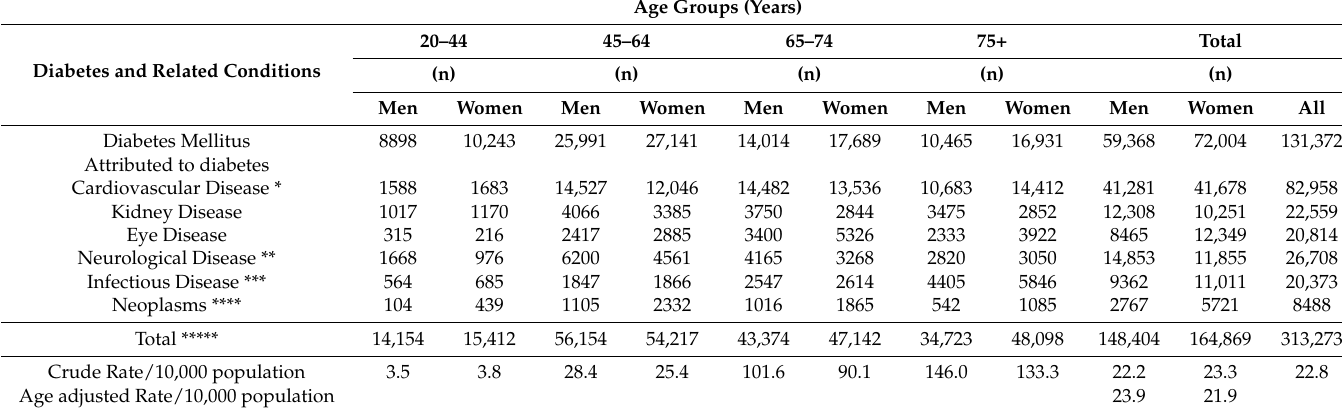
Table 1. Number and rates of hospitalization due to diabetes and related conditions, by age-group and sex, Unified Health System (SUS), Brazil, 2014.